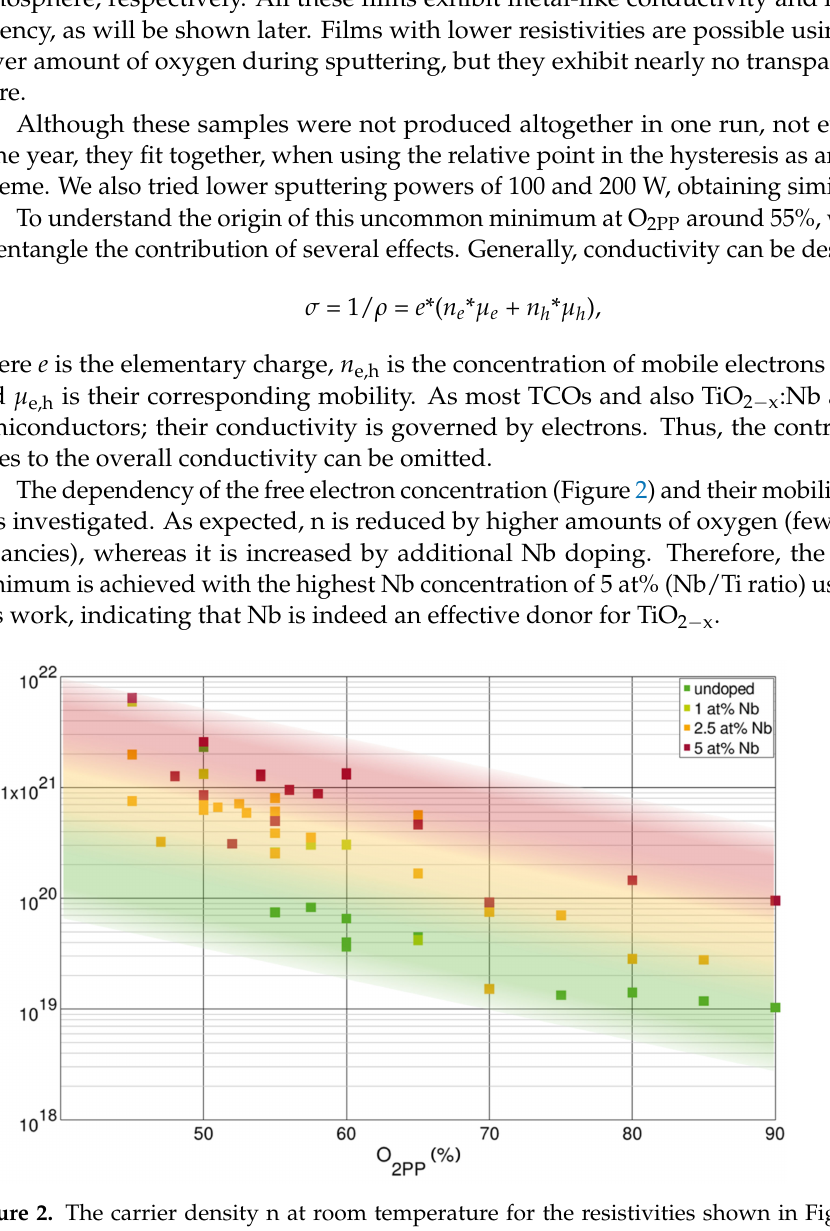
Figure 2. The carrier density n at room temperature for the resistivities shown in Figure 1 with colored areas as guidance to the eye. Reduction of n with increasing O 2PP is expected and typically present in all transparent conducting oxides (TCOs) due to a reduction of oxygen vacancies. Higher densities are obtained at larger Nb concentrations showing that Nb is an effective dopant (donor). However, the minimal resistivity with 5 at% Nb is not proportionally lower than with 2.5 at%, as one might expect. Furthermore, the free electron density does not exhibit a